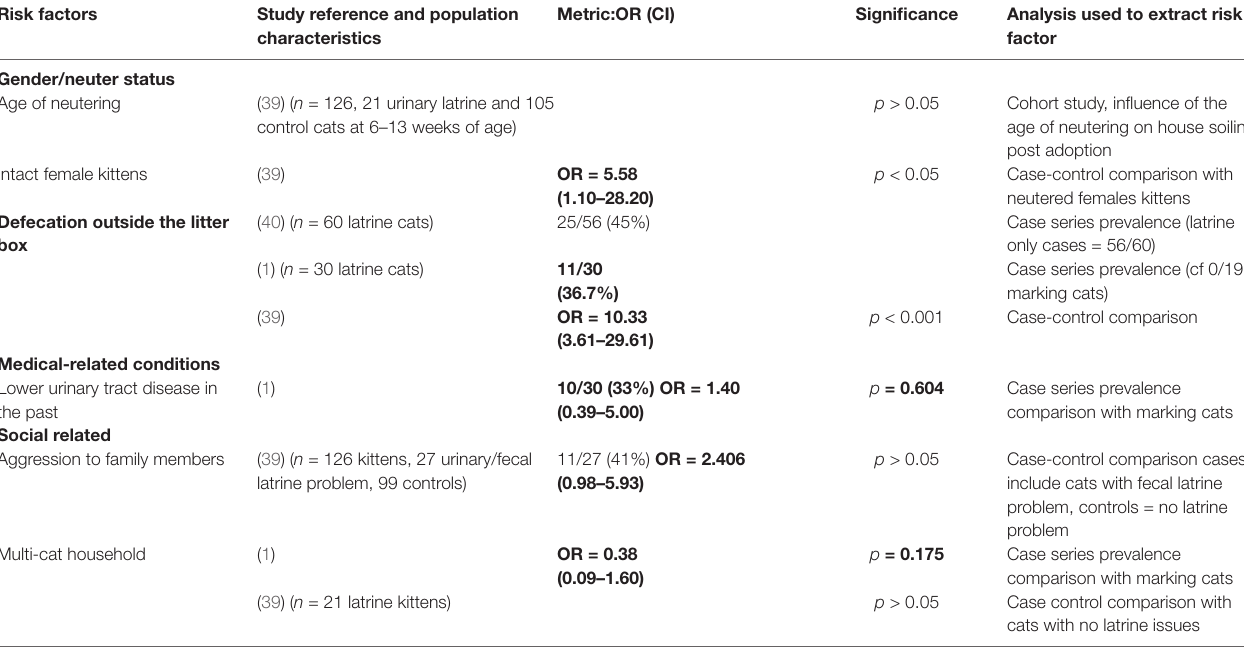
TaBle 2 | Risk factors for urinary latrine problem in the home and associated data from a review of the